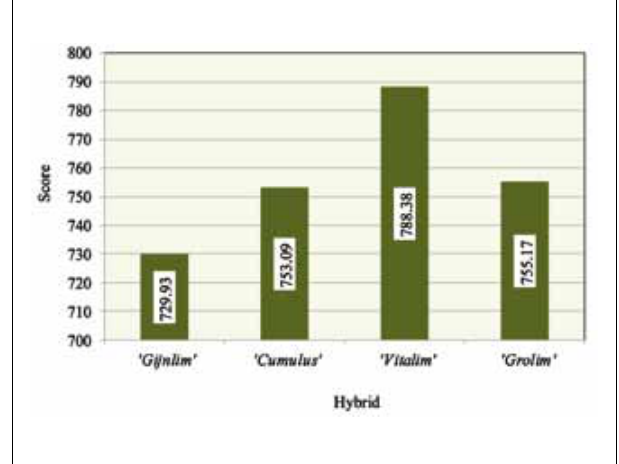
Figure 2. Total score of the hybrids by sensory evaluation (Debrecen- Pallag,